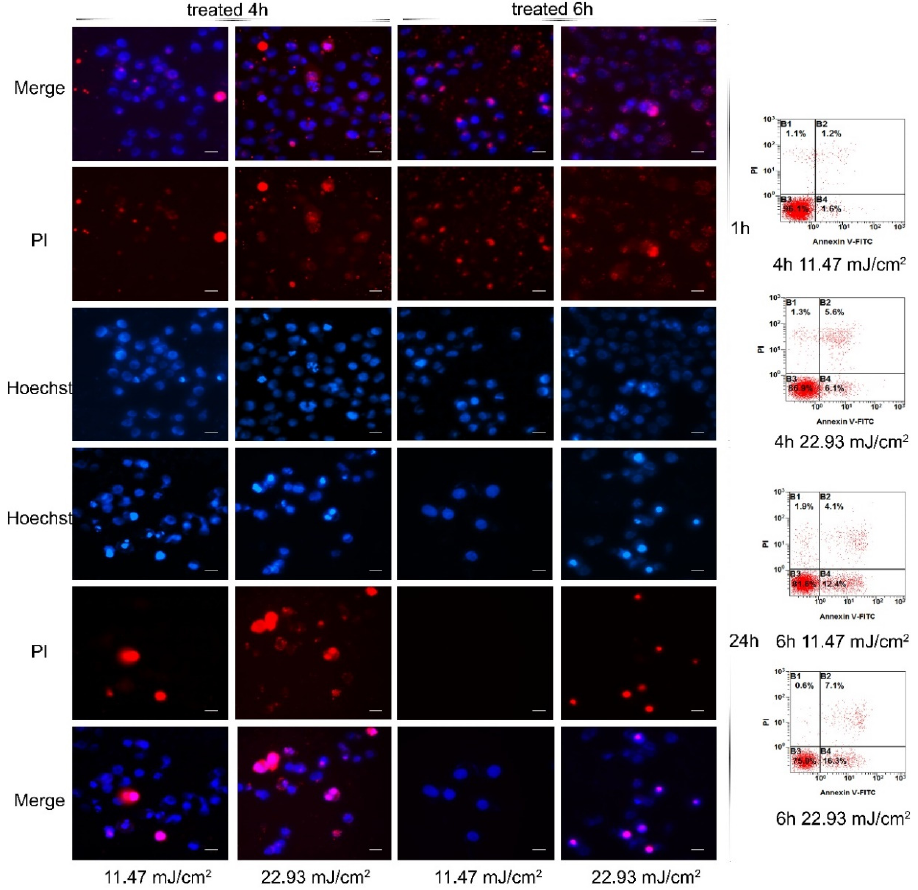
Nanomaterials 2022 , 12 , x FOR PEER REVIEW Figure 6. Apoptosis and necrosis induced by PEG-AuS irradiated with nanosecond laser.